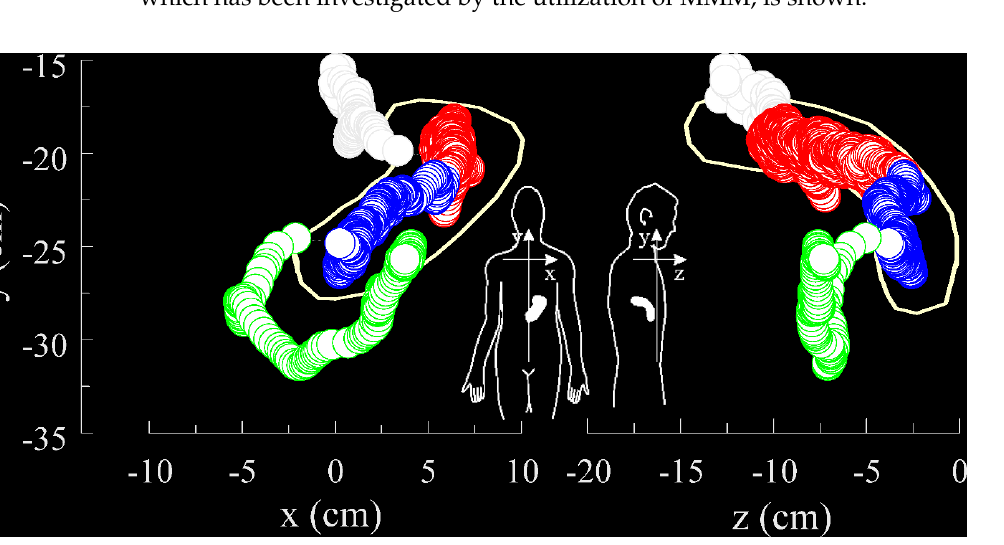
Figure 5. Example of the tracking of a magnetically labelled non-disintegrating capsule in the distal esophagus (grey circles), the proximal stomach (red circles), the distal stomach (blue circles), and the duodenum (green circles) by MMM. Every circle represents a localization step of 40 ms. Reproduced with permission from International Journal of Pharmaceutics , 417, Weitschies and Wilson “In vivo imaging of drug delivery systems in the gastrointestinal tract”, 216– 226, [27], Copyright Else- vier (2011).